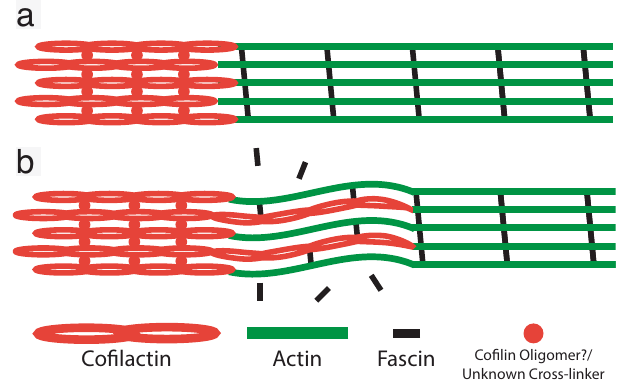
Fig. 8 Current model. Schematic of fi lopodial actin bundle in a rigid ( a ) and fl exible ( b ) state. As co fi lactin fi laments permeate the fascin-linked region of the fi lament, they competitively dislodge fascin cross-linkers and increase the fl exibility of fi lopodial bundles. In the proximal region of the bundles, co fi lactin fi laments prevail and are cross-linked through either co fi lin oligomers/self- association or by some, as of yet, unknown